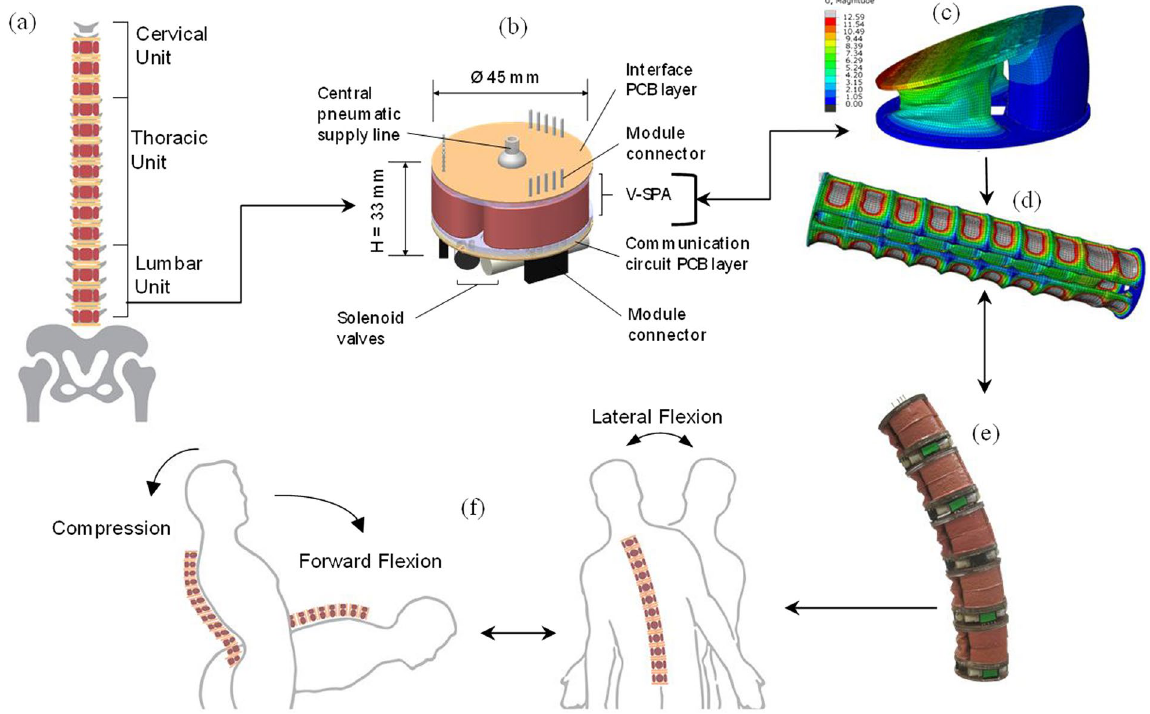
Figure 1. (a) Human spinal column representation comprising of the lumbar unit consisting of the vertebrae, intervertebral discs, spinal cord and other components. (b) Representation of the spinal column unit with a vacuum driven soft pneumatic actuator (V-SPA) module. (c) Numerical simulation results for a single V-SPA module. (d) Simulation results for a pressurized V-SPA module assembly with fixed ends. (e) V-SPA assembly undergoing free bending displacement. (f) Schematic representation of replication and assistance of spinal column motion with the help of the robotic